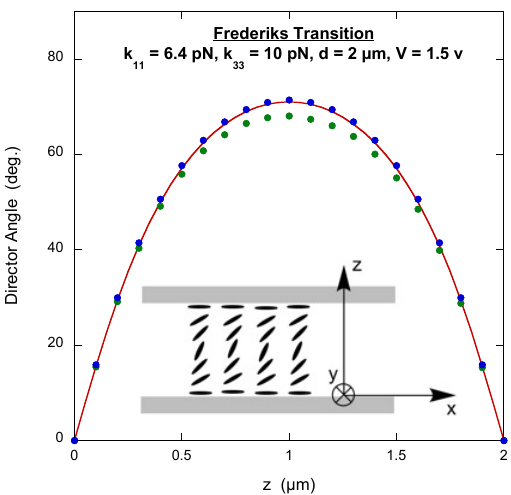
Figure 2. Director angle for the Frederiks transition with ∆ χ = 11 and infinite anchoring strength. Inset: schematic of the cell. The director angle is measured from the x -axis. Green circles: genetic algorithm results for 19 calculation points across the entire cell. Blue circles: genetic algorithm results for 10 calculation points across half the cell. Red line: exact